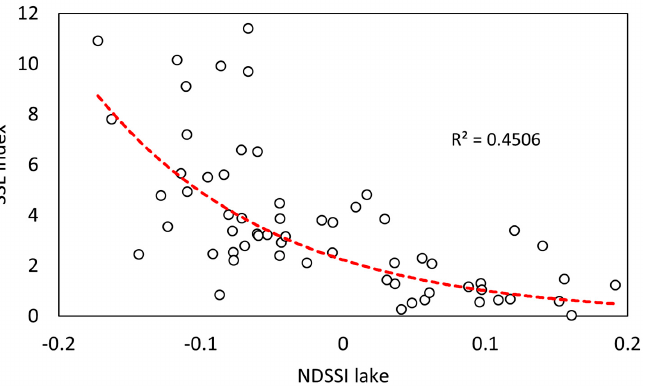
Figure 4. Relationship between lake NDSSI and sediment plume SSL index with the highlighted exponential regression.